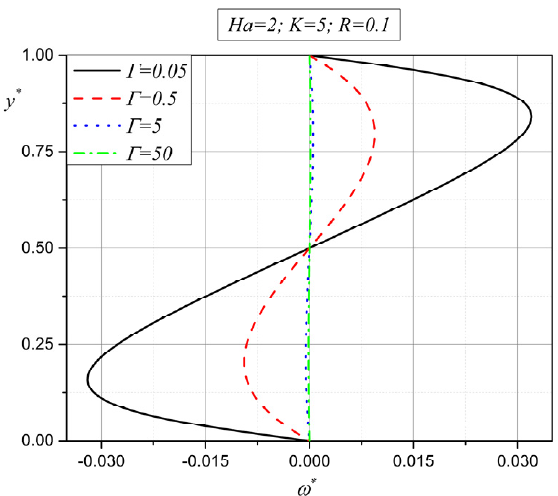
Figure 3. Microrotation for different values of spin viscosity parameter 𝛤 .